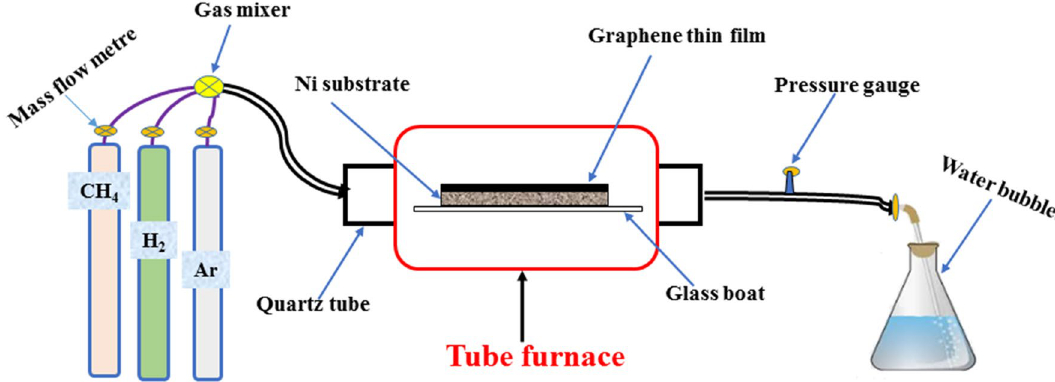
Figure 9. Schematic illustration for the APCVD of G-Ni